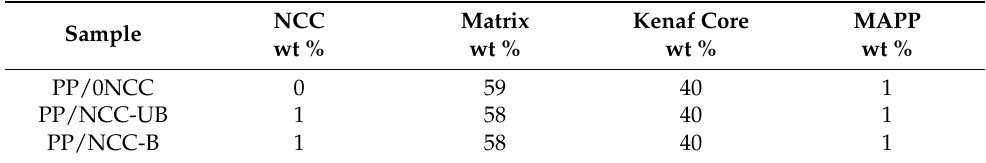
Table 3. The composition and denotation of the kenaf core